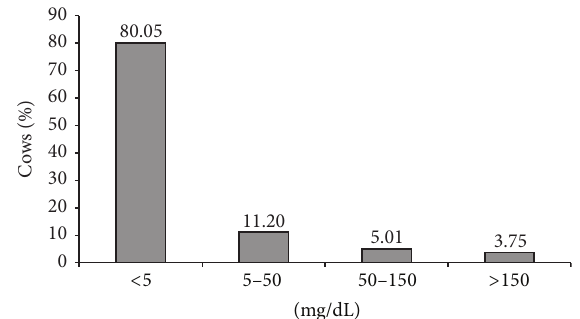
Figure 3: Estimated butyric acid intake in each urine distribution ketosis status: trace, < 5 mg AcAc/dL; low, 5–50 mg AcAc/dL; mod- erate, 50–150 mg AcAc/dL; high, > 150 mg